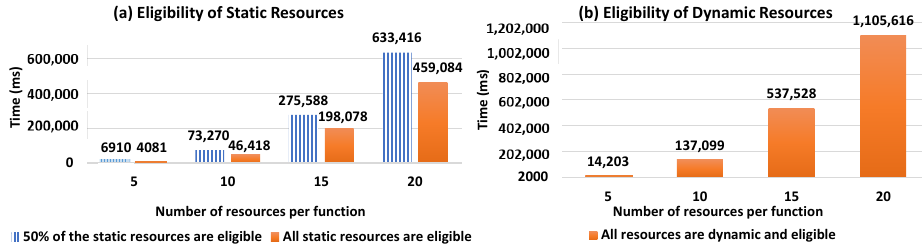
Figure 11. Response time while varying the number of resources.